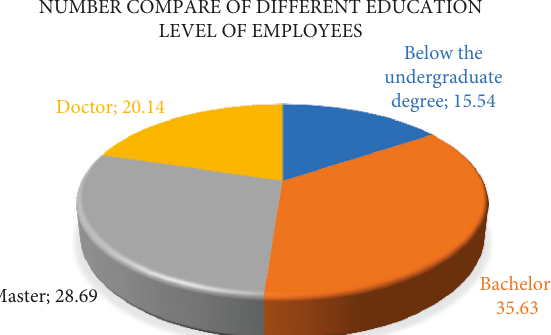
Figure 7: Enterprise employee’s academic degree.